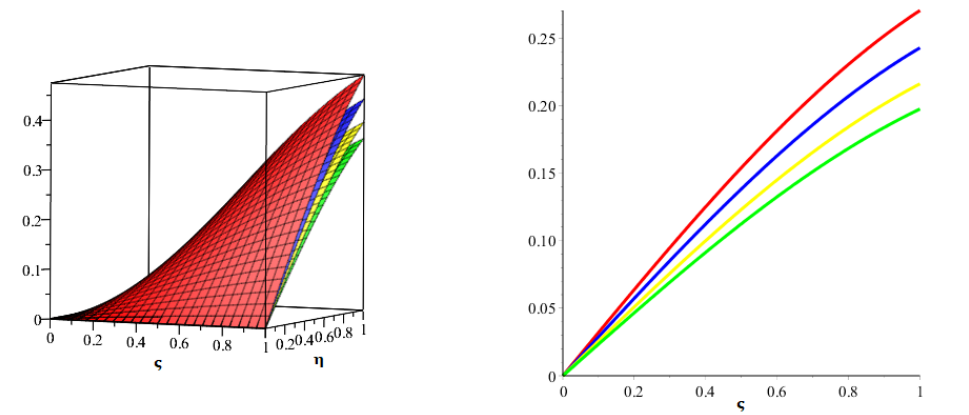
Figure 3. The proposed method solution for problem 1 at different values of γ